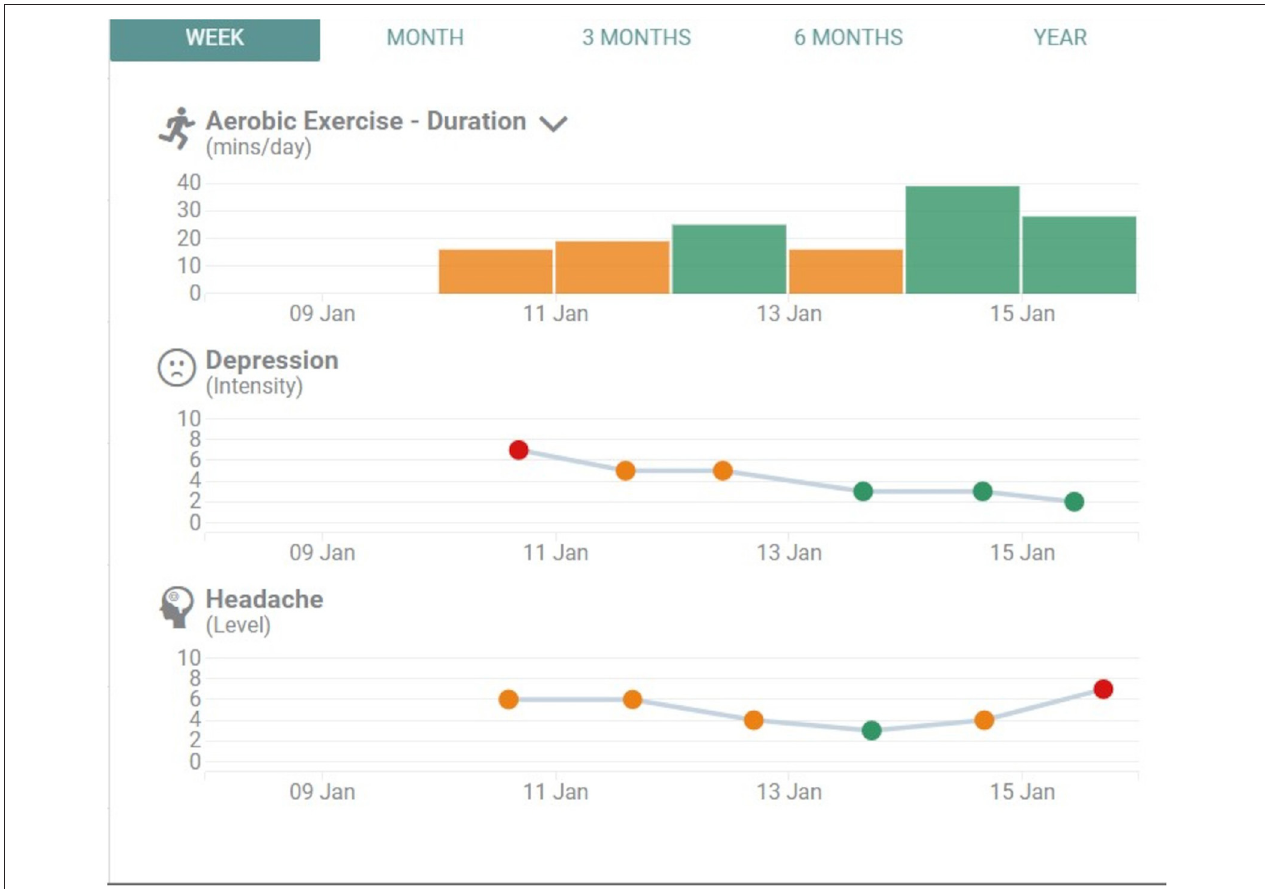
FIGURE 2 | Example of 3 graphs comparing aerobic exercise, depression and headache over a 1-week period. Participants could generate an image showing any 3 symptoms/trackers over different blocks of